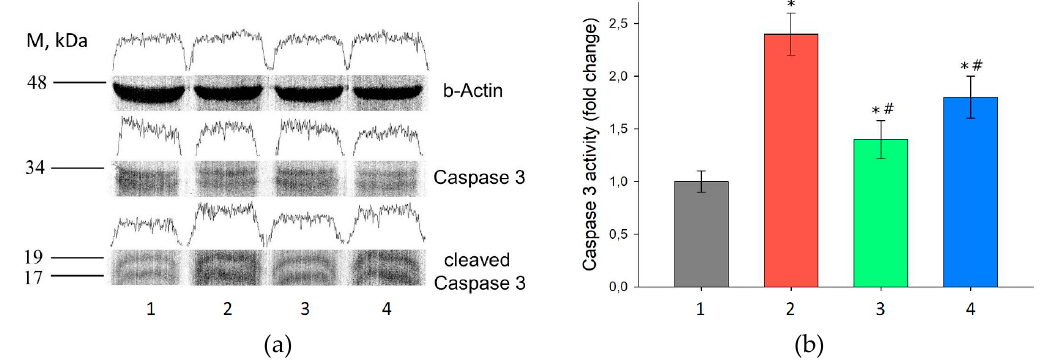
Figure 7. Immunoblotting of kidney tissue for beta Actin and Caspase-3 ( n = 5 for each group). ( a ) WB: 1—Intact mice; 2–24 h after ischemia-reperfusion; 24 h after ischemia-reperfusion injury preceded by injection of Prdx1 (3) and Prx2 (4). Data normalized to beta Actin (45 kDa). ( b ) The level of activation of Caspase-3 was determined by the ratio of pro-Caspase-3 (35 kDa) to cleaved Caspase-3 (17–19 kDa). p ˂ 0.05 relative to the * intact control and # I/R.